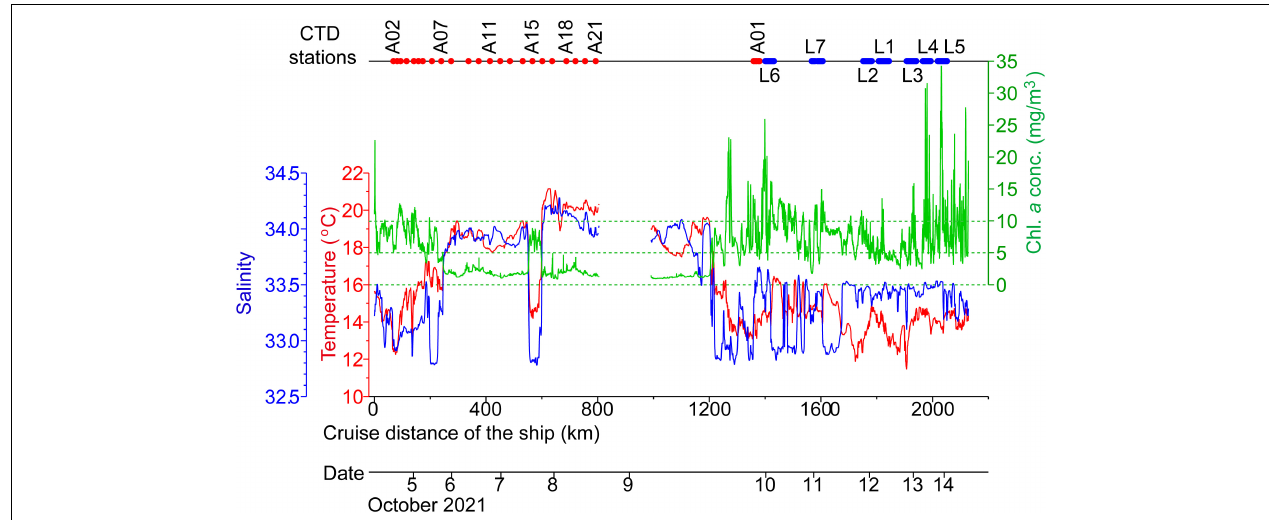
FIGURE 3 | Sea-surface temperatures (red line, corresponding to the red left-hand axis), salinities (blue line, corresponding to the blue left-hand axis), and chlorophyll- a concentrations (green line, corresponding to the green right-hand axis) along the ship track during 4–14 October, 2021. The upper horizontal axis denotes the timing of conductivity–temperature–depth (CTD) measurements.